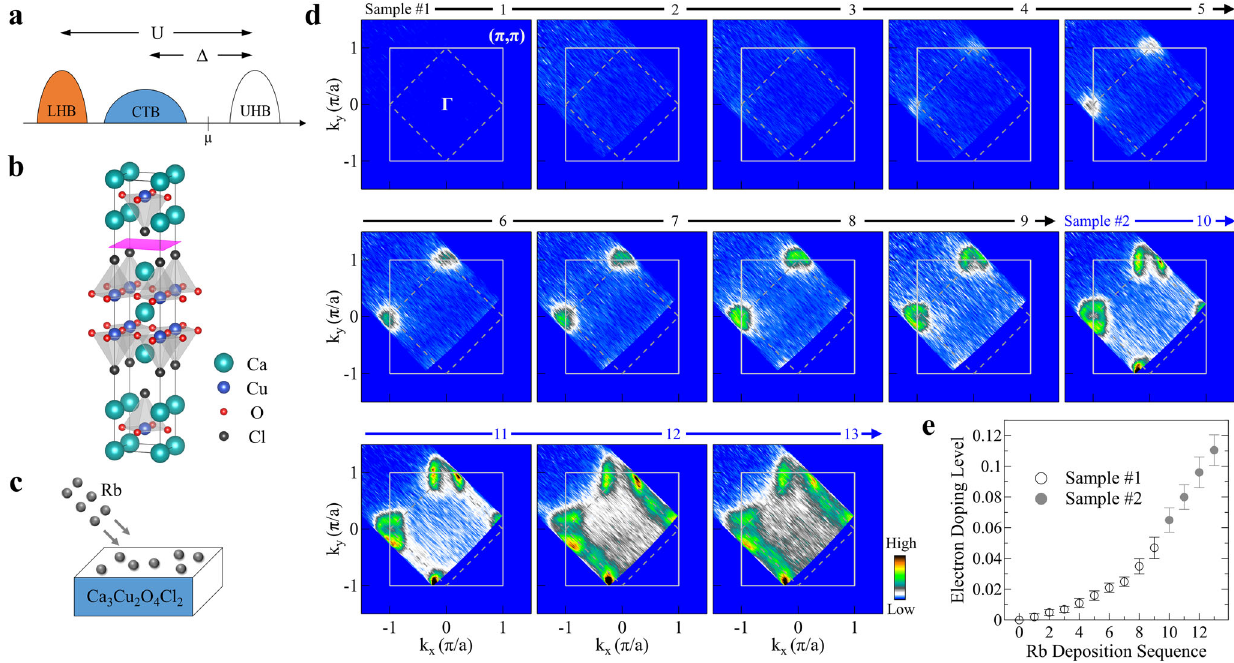
Fig. 1 Fermi surface evolution of Ca 3 Cu 2 O 4 Cl 2 with Rb deposition. a Schematic electronic structure picture of the cuprate parent compound. It consists of the lower Hubbard band (LHB) and upper Hubbard band (UHB) that are separated by the on-site Coulomb repulsion U. The charge-transfer band (CTB) lies in between the LHB and UHB bands, giving rise to a charge-transfer gap Δ . The chemical potential μ is located inside the gapped region. b Crystal structure of CCOC326 consisting of double CuO 2 planes in one structural unit. The crystal cleaves between two adjacent CaCl layers, as marked by the pink sheet. c Schematic illustration of in situ Rb deposition onto the sample surface. Electrons are transferred into the top layers due to the physical absorption of Rb on the sample surface. d Fermi surface mapping of CCOC326 at different Rb-deposition stages. For convenience, we use 0 – 13 to denote the deposition sequence where 0 represents the original sample before Rb deposition. The images for sequences 0 – 9 are obtained on one sample while sequences 10 – 13 are obtained from another sample that complements each other. The Fermi surface images are obtained by integrating the spectral weight over an energy window of [ − 0.03, 0.03] eV with respect to the Fermi level. e Estimated electron doping level after each Rb-deposition stage. For the deposition stages from 3 to 11, the electron doping level is calculated from the area of the electron-like Fermi surface centered at ( − π , 0). For the deposition sequences 12 and 13, it is estimated from the area of the hole-like Fermi surface centered at ( − π , π ). The doping level for deposition stages 1 and 2 are obtained by linear extrapolation in the low doping region according to the deposition procedures. Error bars re fl ect the uncertainty in determining the Fermi